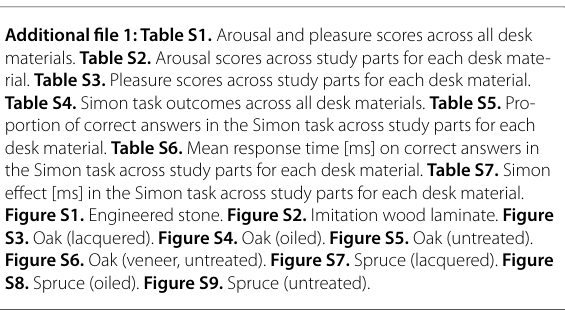
Additional file 1: Table S1. Arousal and pleasure scores across all desk materials. Table S2. Arousal scores across study parts for each desk mate- rial. Table S3. Pleasure scores across study parts for each desk material. Table S4. Simon task outcomes across all desk materials. Table S5. Pro-